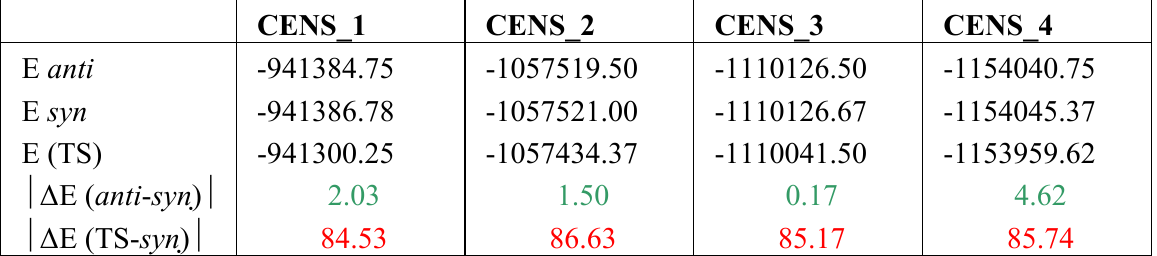
Table 7: The relative energy (kcal/mol) of the anti , syn and TS structures of the four CENS calculated by the RHF method with a minimal STO- 3G basis function.